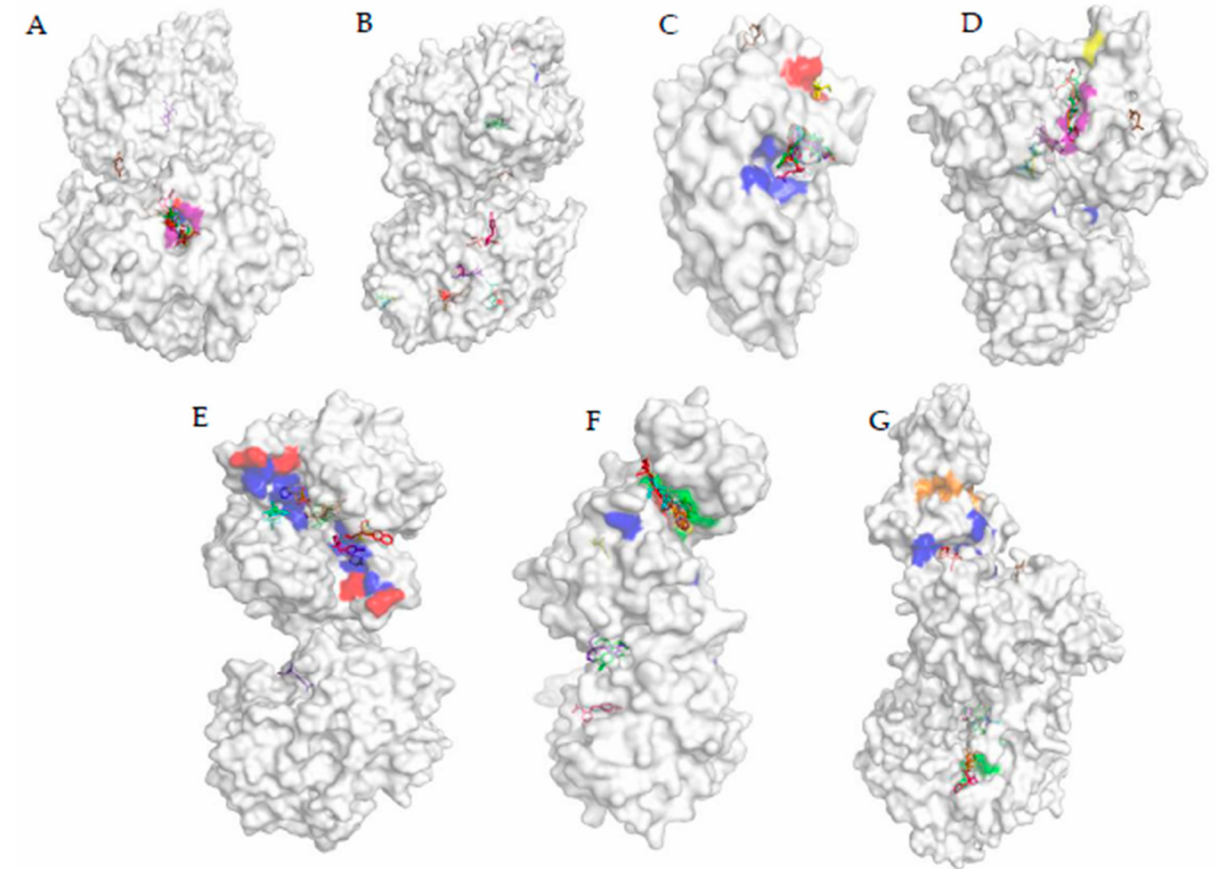
Figure 4. The surface topological view of enzymes where the binding location of ligands are shown relative to important site of enzymes. ( A ) AChE, blue—activity site residues, red—reactivator sit residues, purple—residues that are part of both active and reactivator site. ( B ) CP450, blue—activity site residues, and red—reactivator site residues. ( C ) GLS, blue—activity site residues, red—inhibitor site residues. ( D ) PKC, blue—autophosphorylation site residues, purple—active/inhibitory site residues and yellow—ATP binding site residues. ( E ) GST, blue—activity site residues, red—inhibitor site residues. ( F ) ASK1, yellow—activity site residues, green—ATP binding site, red—inhibition site, and blue—autophosphorylation site. ( G ) AMPK, blue—activity site residues, green—AMP binding site, and orange—activator